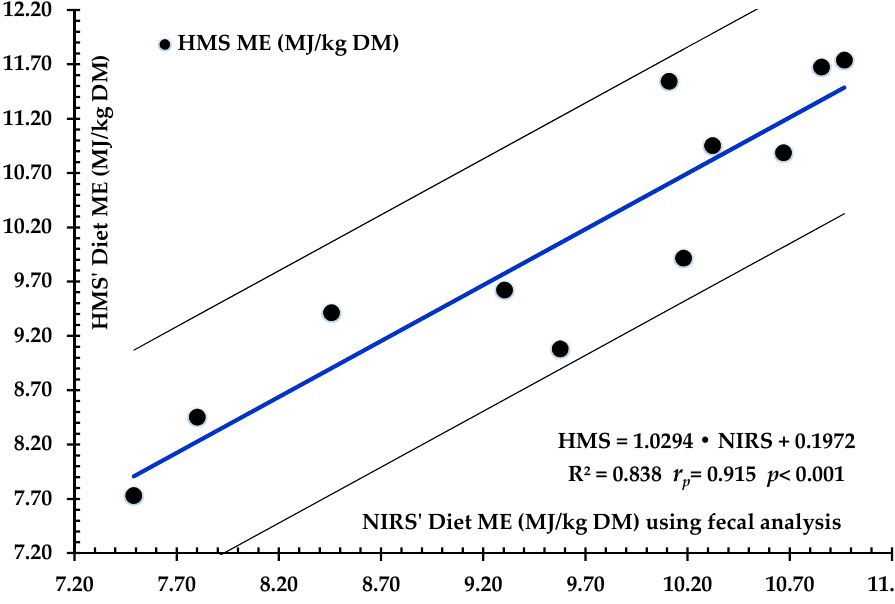
Figure 1. Correlation of the cows’ consumed dietary ME (MJ/kg DM) calculated by the HMS with that calculated by fecal NIRS analysis. Period length of 14 months. The two black lines represent the 95% confidence interval of the regression slope (the blue line).